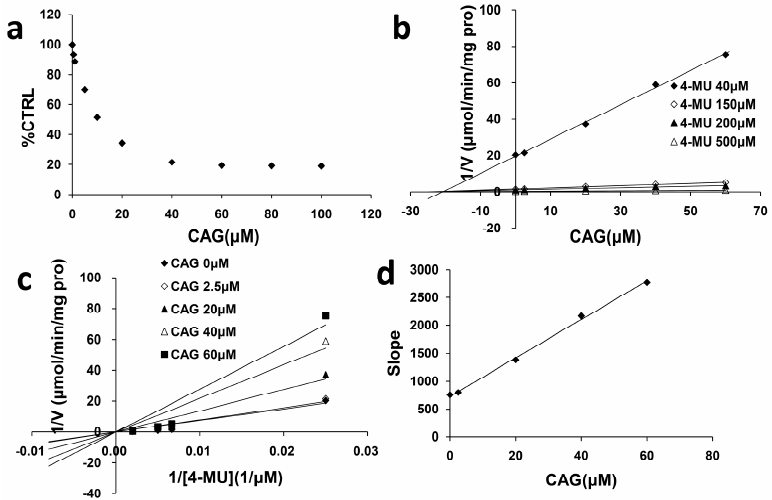
Figure 4. Determination of inhibition type and parameters ( Ki ) of CAG towards UGT2B7. ( a ) Dose-dependent inhibition of CAG towards UGT2B7; ( b ) Dixon plot of inhibition of CAG towards UGT2B7; ( c ) Lineweaver-Burk plot of inhibition of CAG towards UGT2B7; ( d ) Second plot of inhibition of CAG towards UGT2B7. The data point represents the mean value of duplicate experiments.